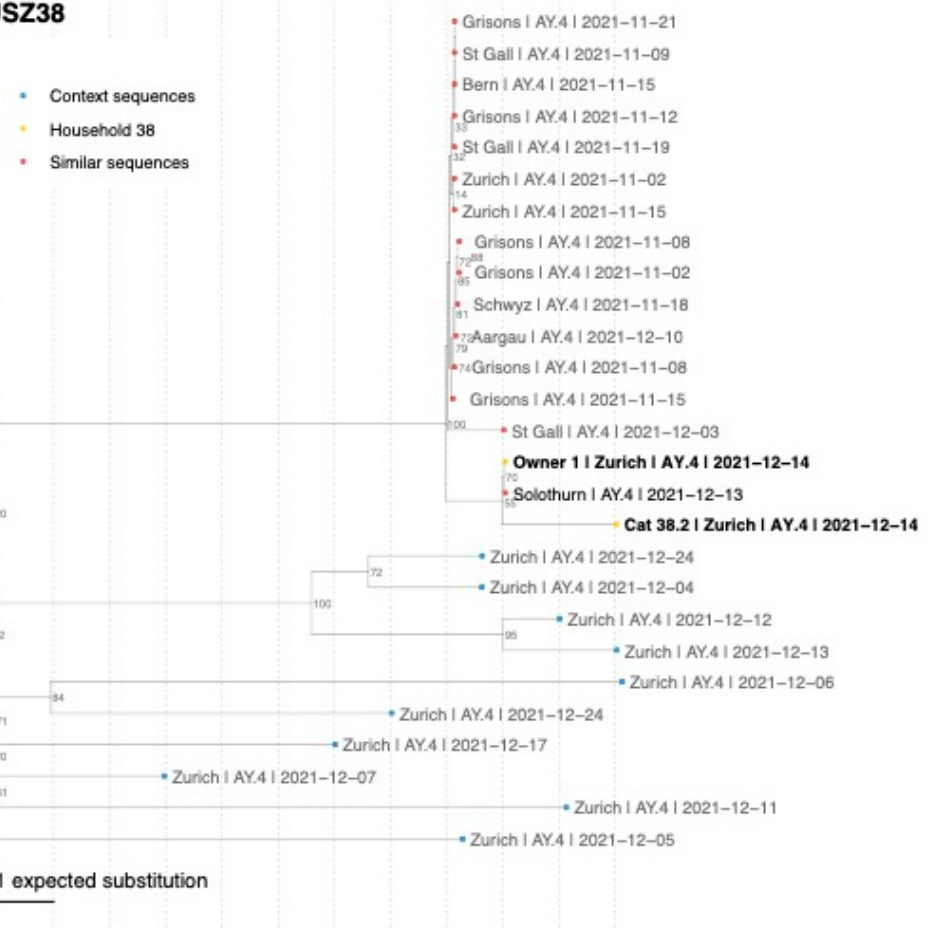
Figure A4. Maximum-likelihood phylogenetic tree showing the relationship between the three sequences of USZ38 (yellow dots and bold text) and their respective 10 most genetically similar Swiss sequences from GISAID. The most similar sequences (red dots) are defined as those with the smaller number of SNPs differences to each household sequence (sequences that are part of the 10 closest sequences for several of the household sequences only appear once in the tree). Blue dots indicate a representative set of 10 sequences circulating in Zurich in November–December 2021 from pangolin lineage AY.4 (context sequences). Location, pangolin lineage, and collection date are shown for each sequence. Bootstrap values for the internal nodes are shown next to each node from 10,000 bootstrap replicates.